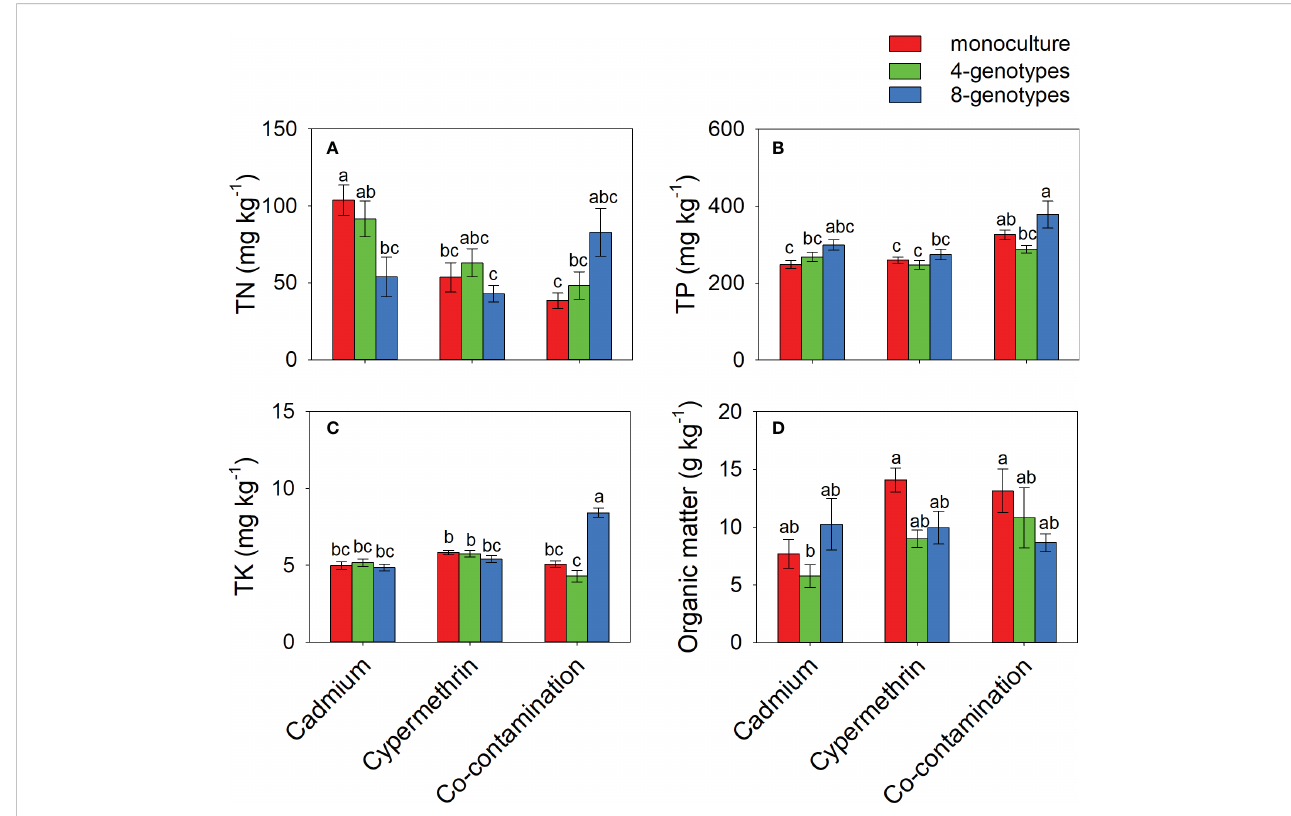
FIGURE 3 Total nitrogen ( A ; TN), total phosphorus (B) , total potassium ( C ; TP) and organic matters (D) in the soil grown with Hydrocotyle vulgaris populations of different number of genotypes under different pollutant treatments. Mean values ( ± 1 SE) are presented. Letters (a-c) above the bars indicate signi fi cant differences (P < 0.05) among each panel. See Table 1C for ANOVA